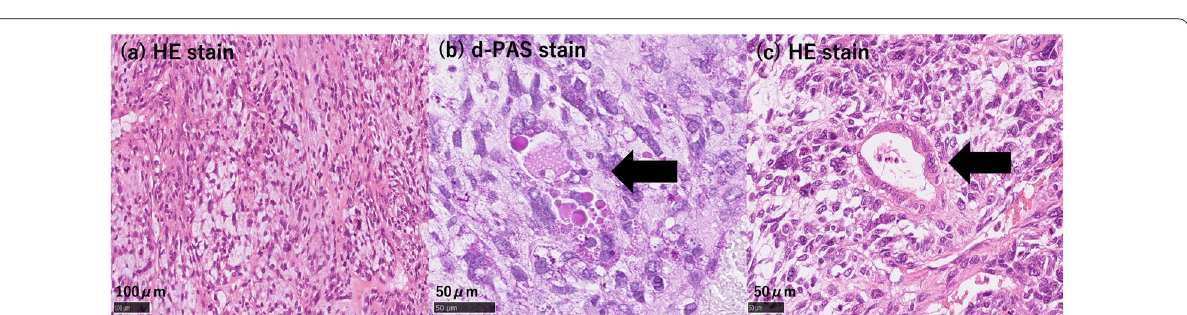
200, HE stain). b Some tumor cells contain eosinophilic globules, which are ×